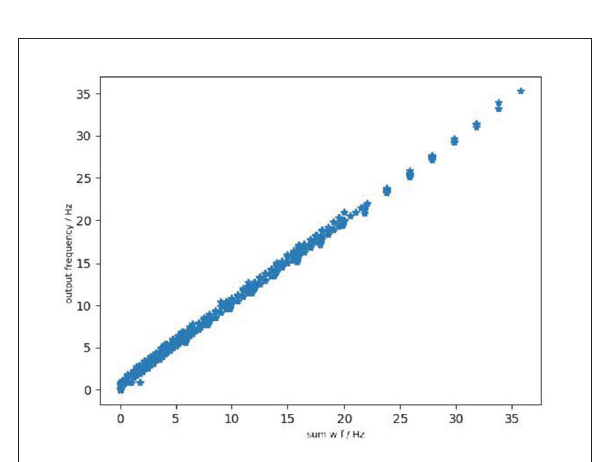
FIGURE9 The relationship between output of ReLU-AN model and Linear LIF model when the three input signals have differen